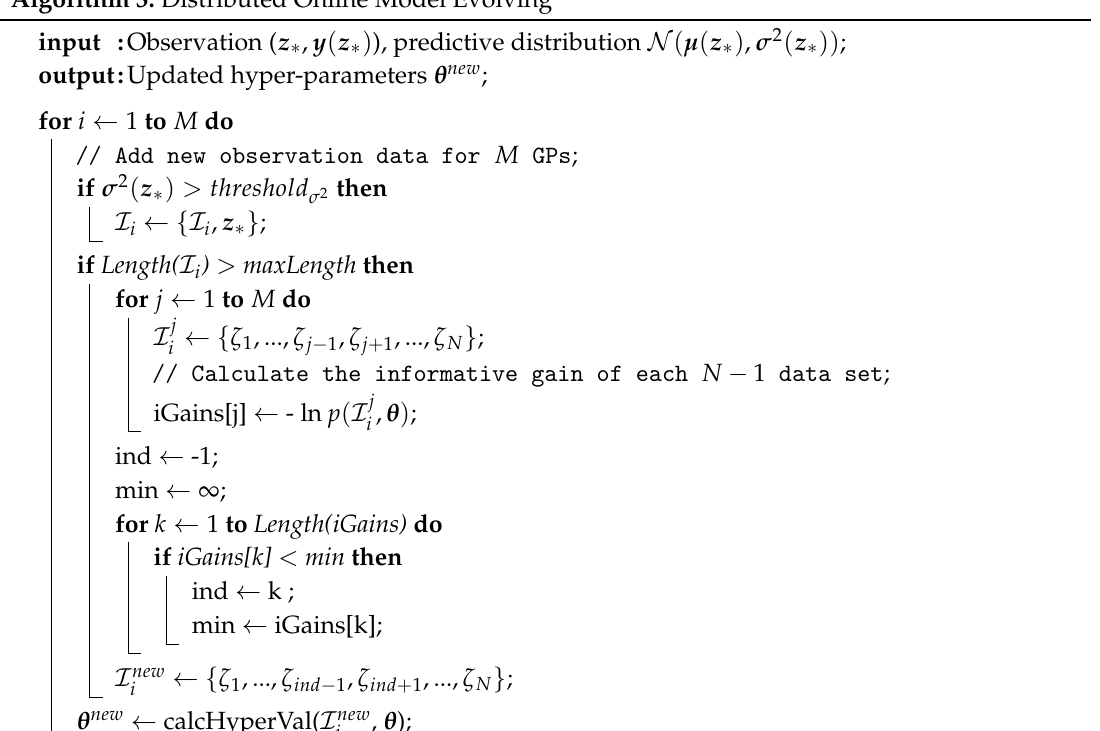
Algorithm 3: Distributed Online Model